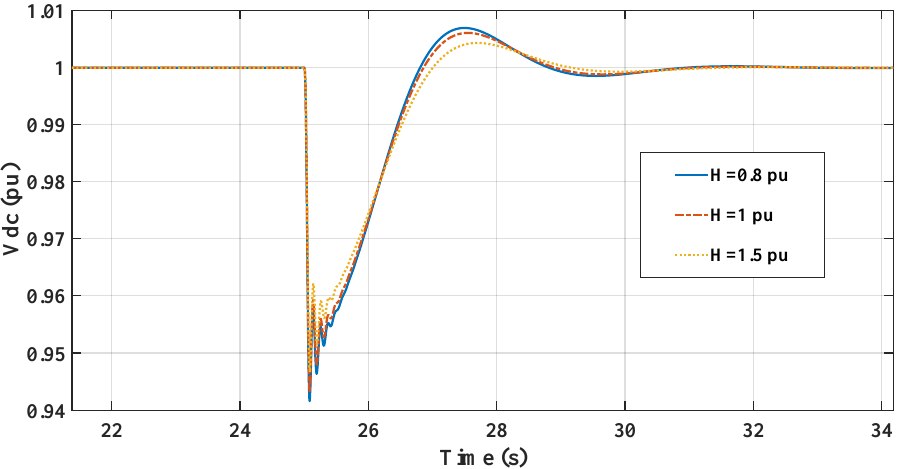
Figure 19. DC bus voltage at different generator